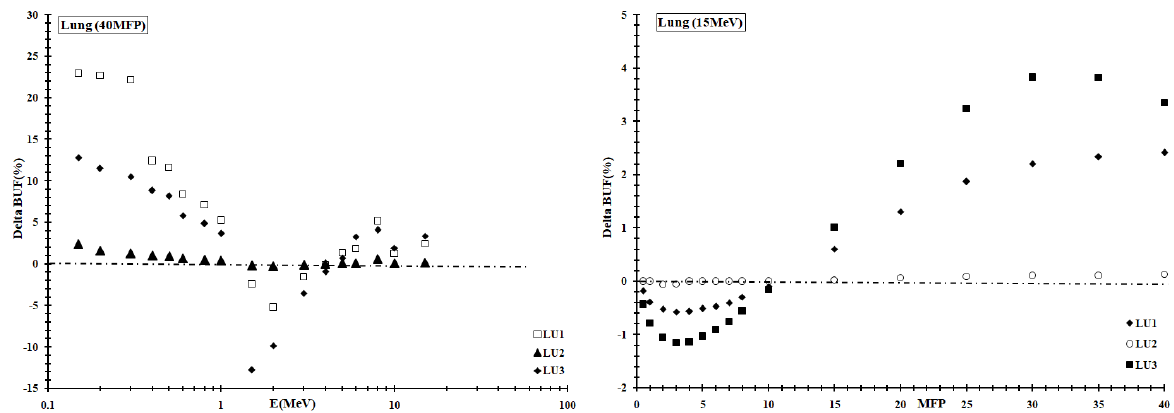
Figure 11. Relative percentage deviation of the BUF values of substitute materials for lung tissue as a function of: ( left side ) photon energy for fixed depths of 0.5, 15 and 40 mfp and ( right side ) depth for fixed photon energies of 0.5, 5 and 15 MeV.